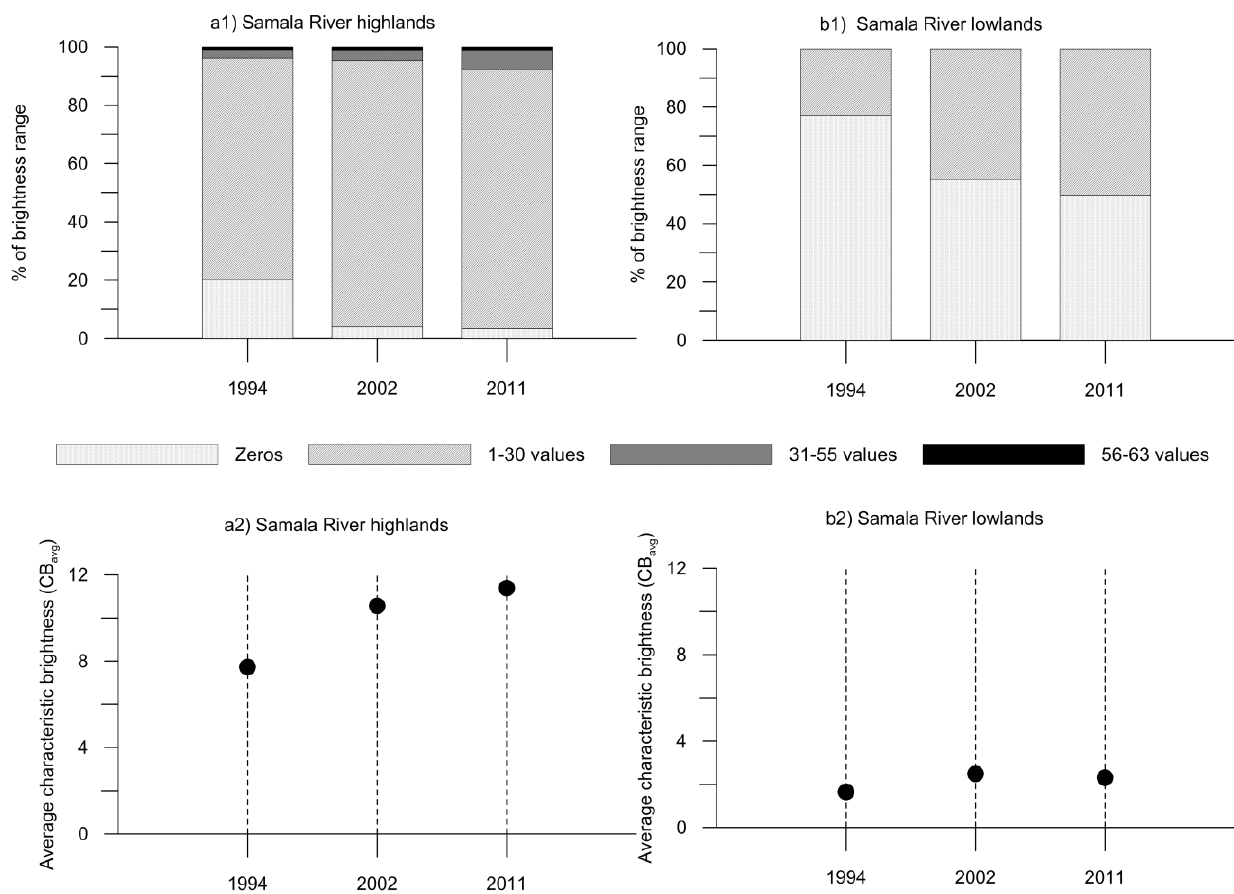
Figure 6. Nightlights in the highlands and lowlands of the Samala River catchment over time. The evolution in time of nightlight cells is shown separately for the highlands and the lowlands in terms of ( a1 , b1 ) distribution of cells per brightness ranges and ( a2 , b2 ) characteristic average digital number